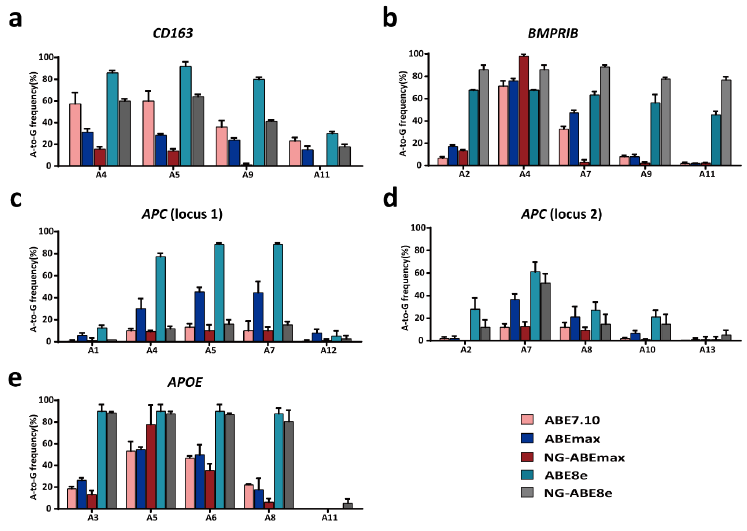
Figure 2. ABE-mediated A-to-G conversion efficiencies at the CD163 ( a ), BMPRIB ( b ), APC (locus 1) ( c ), APC (locus 2) ( d ) and APOE ( e ) gene loci with puromycin selection in the PFFs and using multiple ABEs. -n = 3, independent replicates.